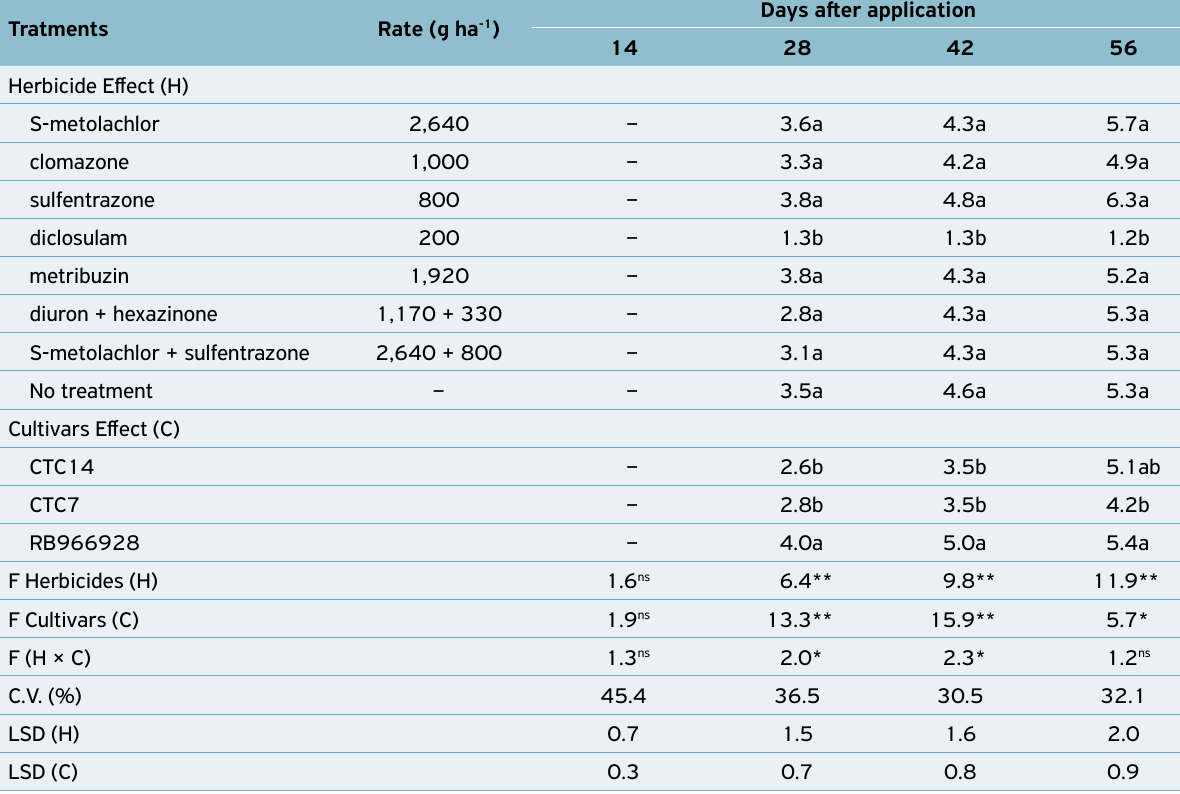
Table 4. Mean values of number of tillers caused by different herbicides applied in pre-planting to three sugar cane cultivars. Pradópolis, state of São Paulo, Brazil,